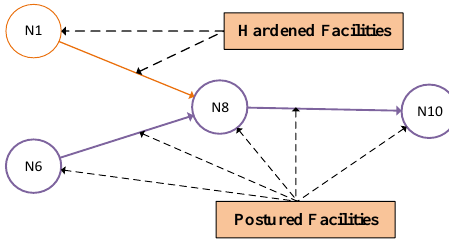
Figure 7. The model validated to include the most important facilities in the investment plan.